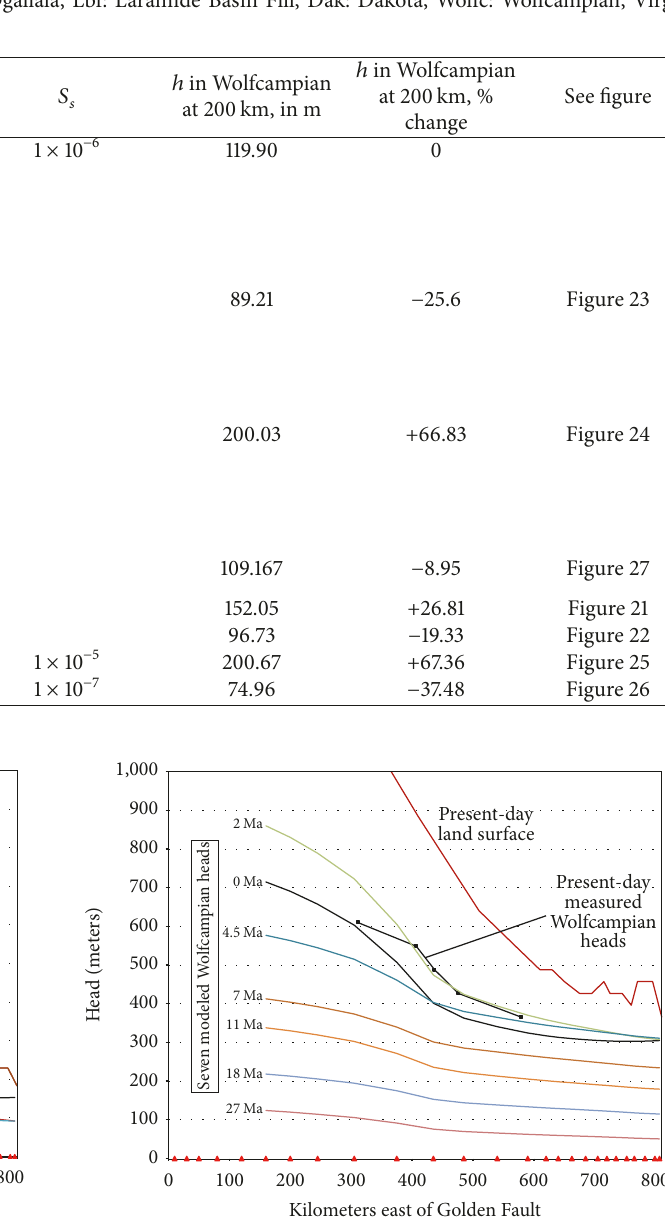
Figure 32: Progression of Wolfcampian head solutions from 27 to 0